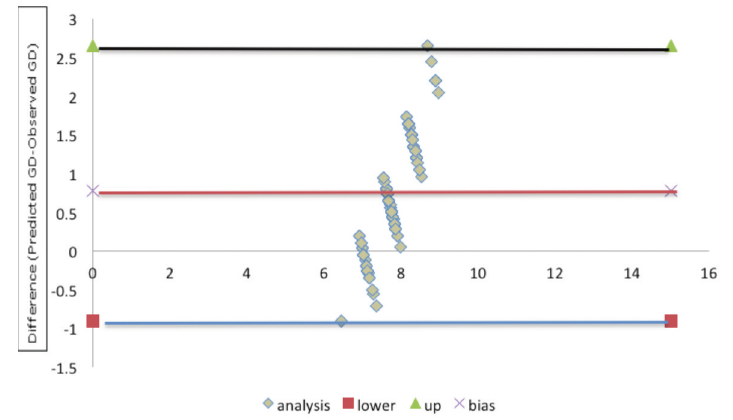
Bland Altman analysis of predicted versus observed graft diameter. Co-relation (R) =0.64 and p value <0.0001. confidence Fig. 4: interval